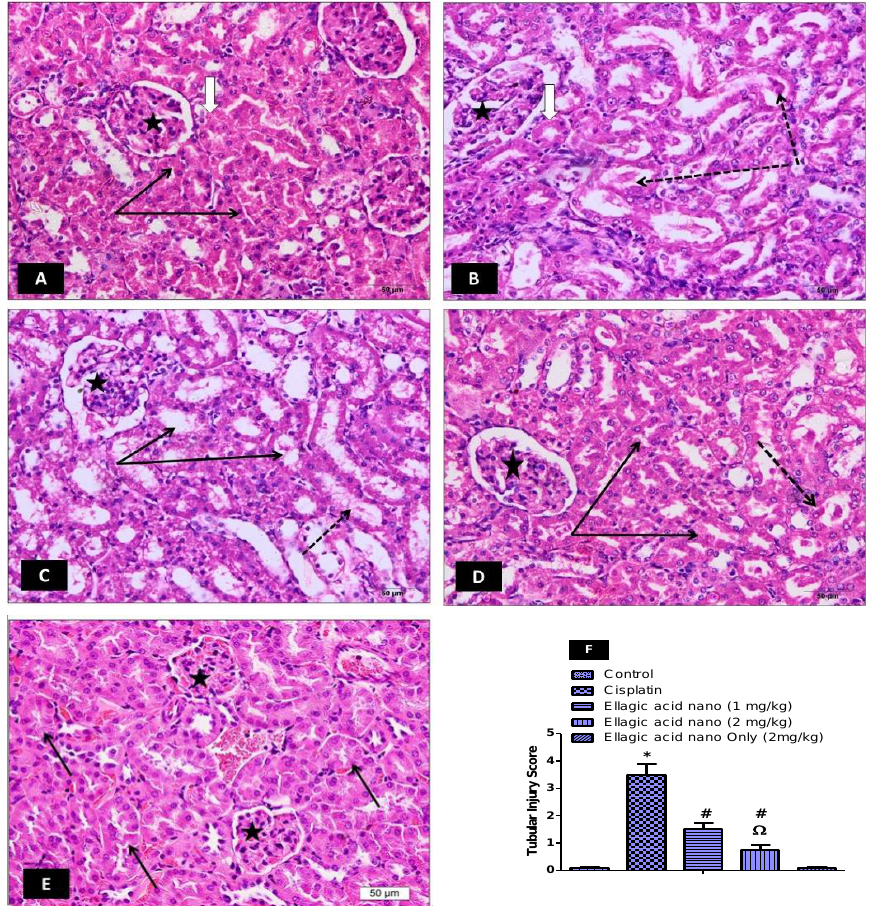
Figure 1. Impact of ellagic acid nanoformulation on kidney histopathology examined in cisplatin- (7.5 mg / kg) treated rats. ( A ) Control: normal kidney parenchyma, renal corpuscle, glomeruli (white arrow and star), narrow lumen proximal tubules, and normal epithelial lining (black arrows). ( B ) Cisplatin: dilated proximal tubules with lumen containing pretentious casts (dotted arrows). Other tubules exhibited dark apoptotic cells with degenerated nuclei (white arrow). Mild changes were observed in the renal glomeruli (stars). ( C ) Ellagic acid nano (1 mg / kg): mildly dilated lumen proximal tubules and renal glomeruli (stars), also few containing casts (dotted arrow). ( D ) Ellagic acid nano (2 mg / kg): marked improvement in proximal tubules (black arrows). This section looked mostly free from casts (dotted arrow). ( E ) Ellagic acid nano only (2 mg / kg): normal renal corpuscles with their glomeruli (stars) and normal renal tubules (black arrows). ( F ) Semiquantitative tubular injury score. Results were presented as mean ± SE (n = 6). * p ≤ 0.05 relative to the control group; # p ≤ 0.05 relative to cisplatin group; Ω p ≤ 0.05 relative to ellagic acid nano (1 mg / kg)